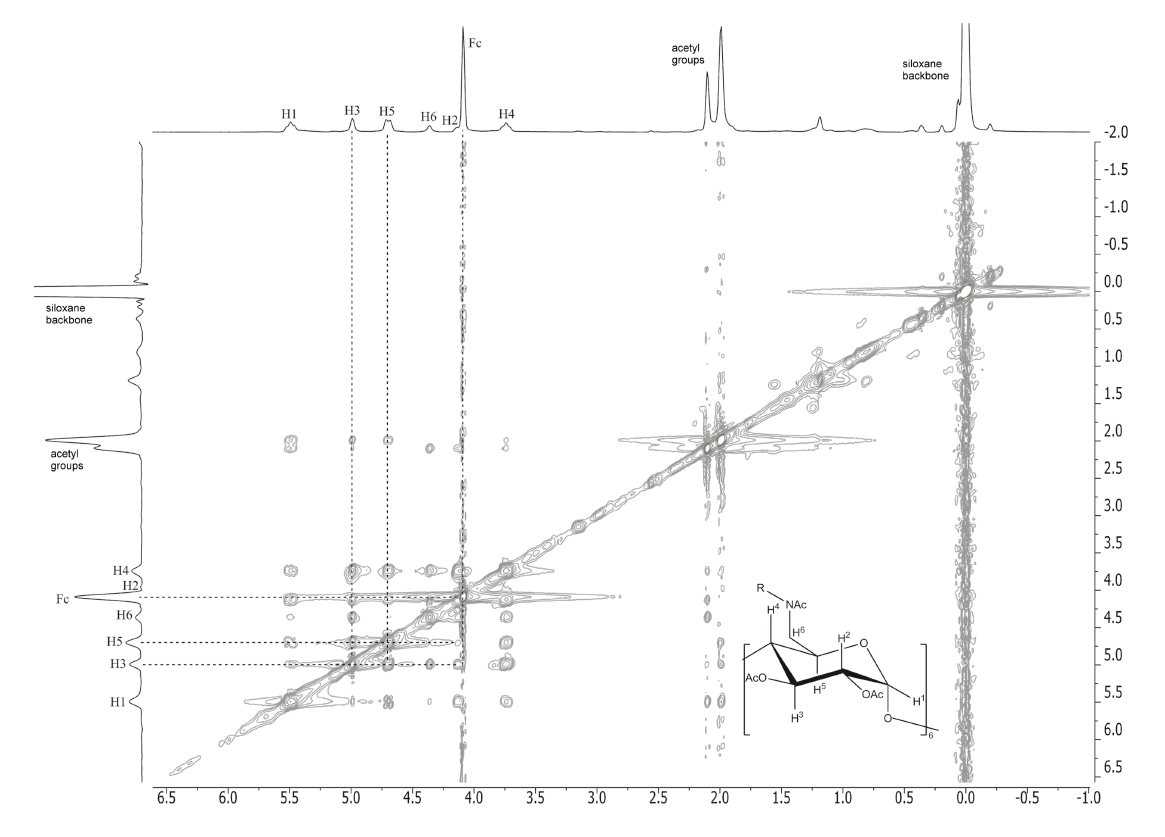
Figure 3: 2D ROESY NMR spectra of the complex of α -CD-disiloxane ( α -CD-DS) 4 with ferrocene.